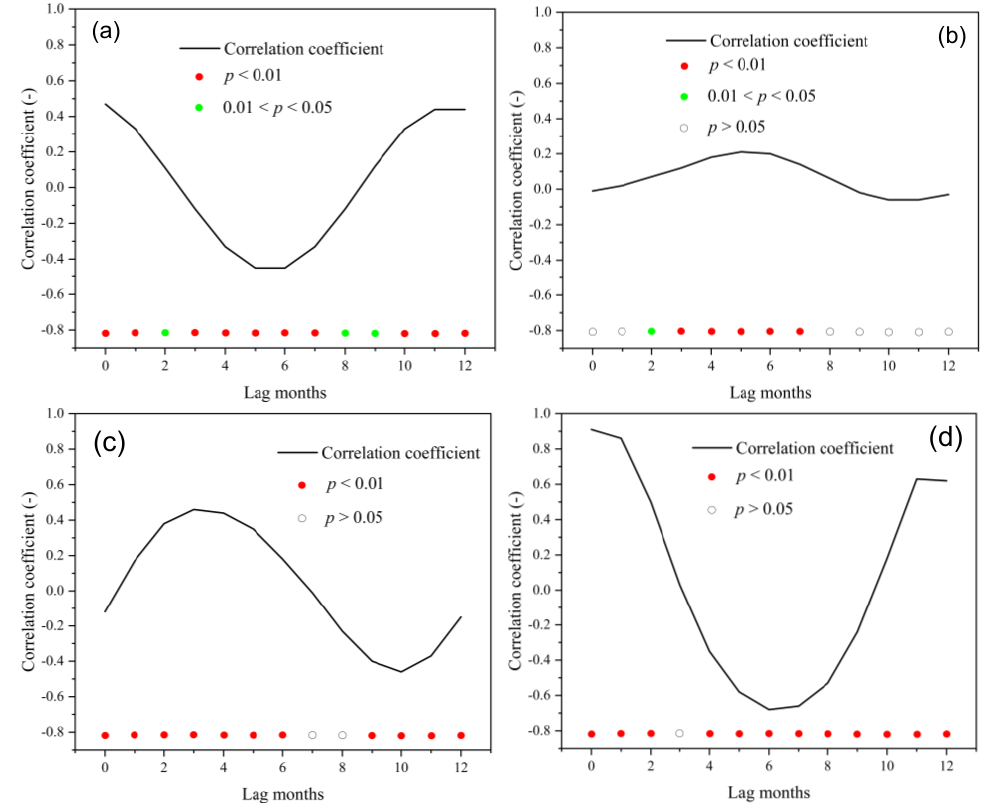
Figure 11. Temporal variation lag effect of precipitation on vegetation LAI in four study regions: ( a ) North America, ( b ) Mediterranean region, ( c ) Central Asia, and ( d ) East Asia.